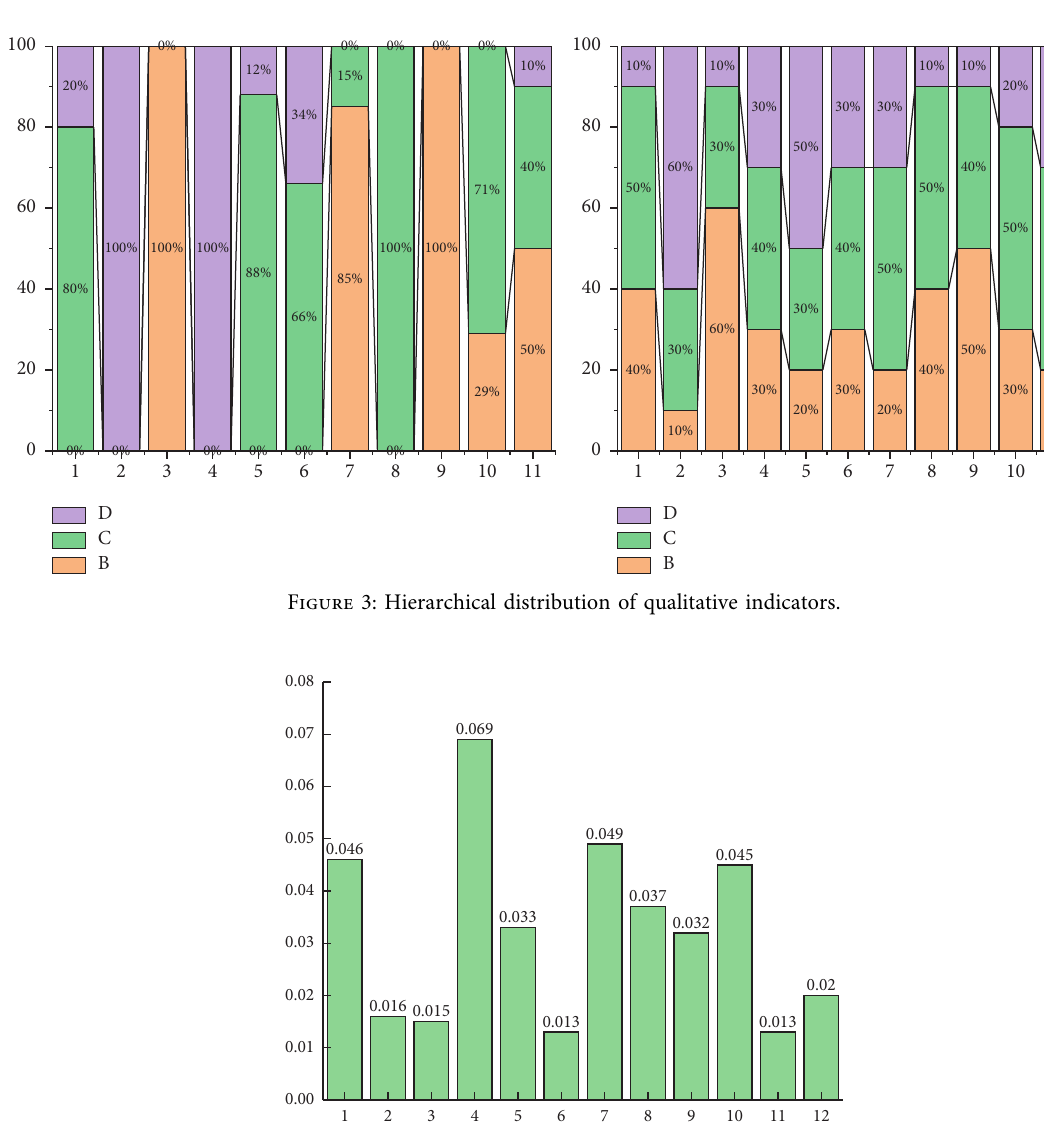
Figure 4: Weight comparison between the indicator layer and target layer.